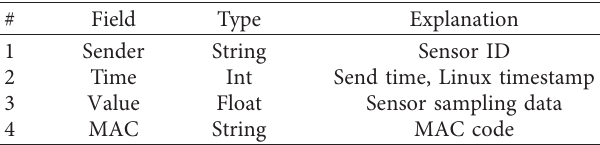
Figure 3: Sensor and node key agreement protocol. Table 1: Sensor transaction